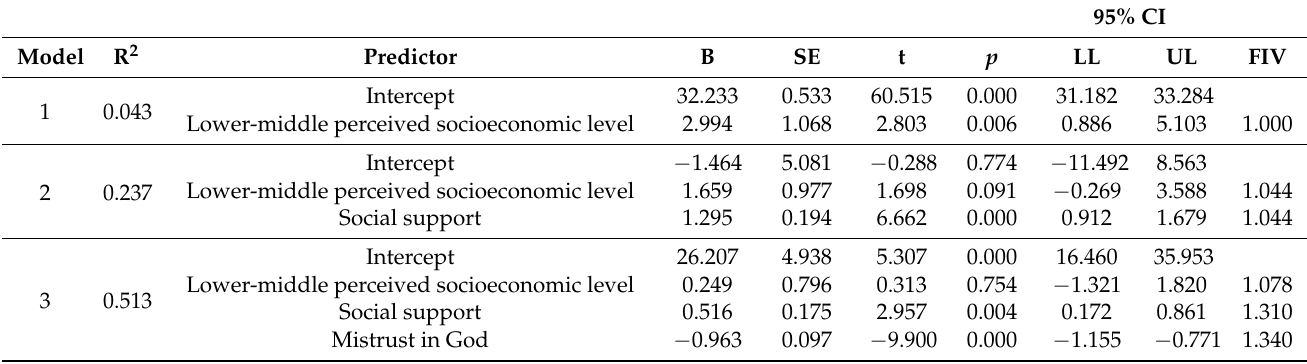
Table 3. Predictive models of PANAS positive